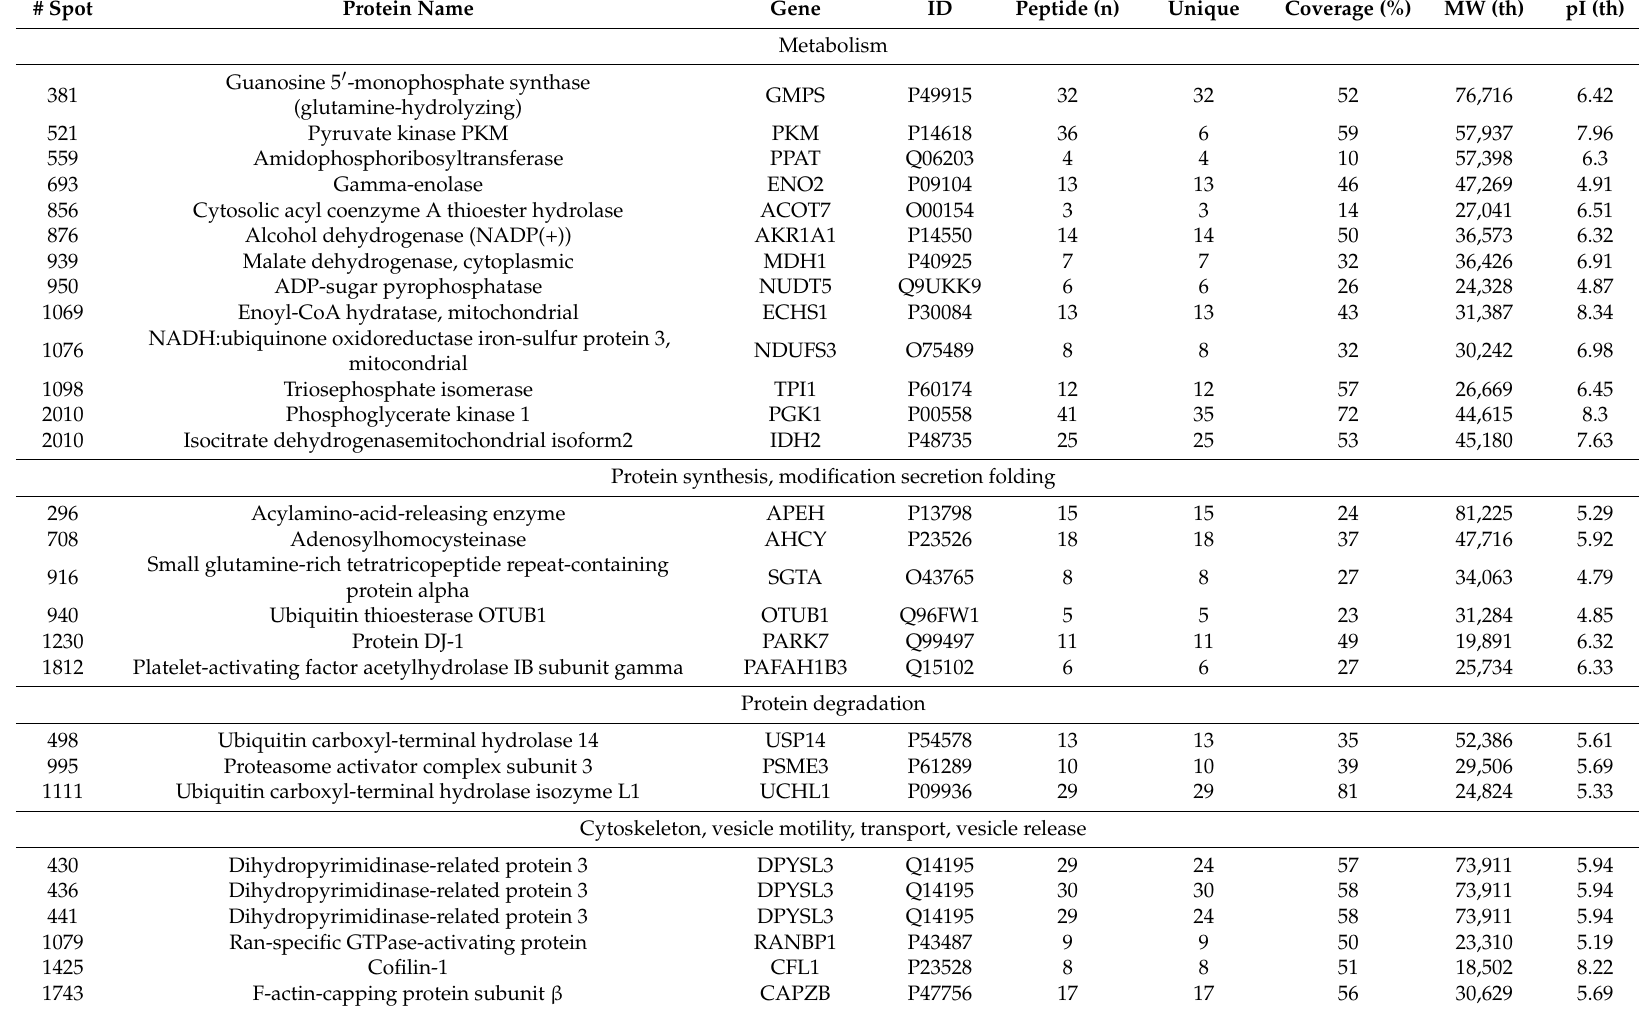
Table 1. MS/MS data of protein spots differentially expressed grouped by functional class. MW, molecular weight; pI, isoelectric point; th,